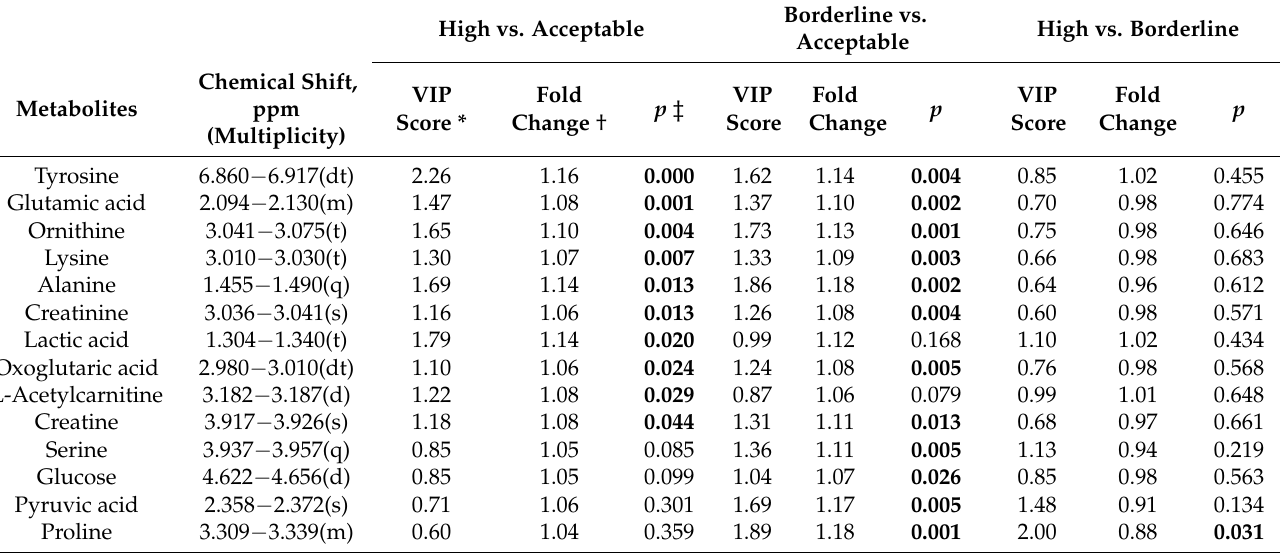
Table 2. The VIP score and fold change of metabolites significantly differentially expressed between children with different cholesterol levels. High vs. Acceptable